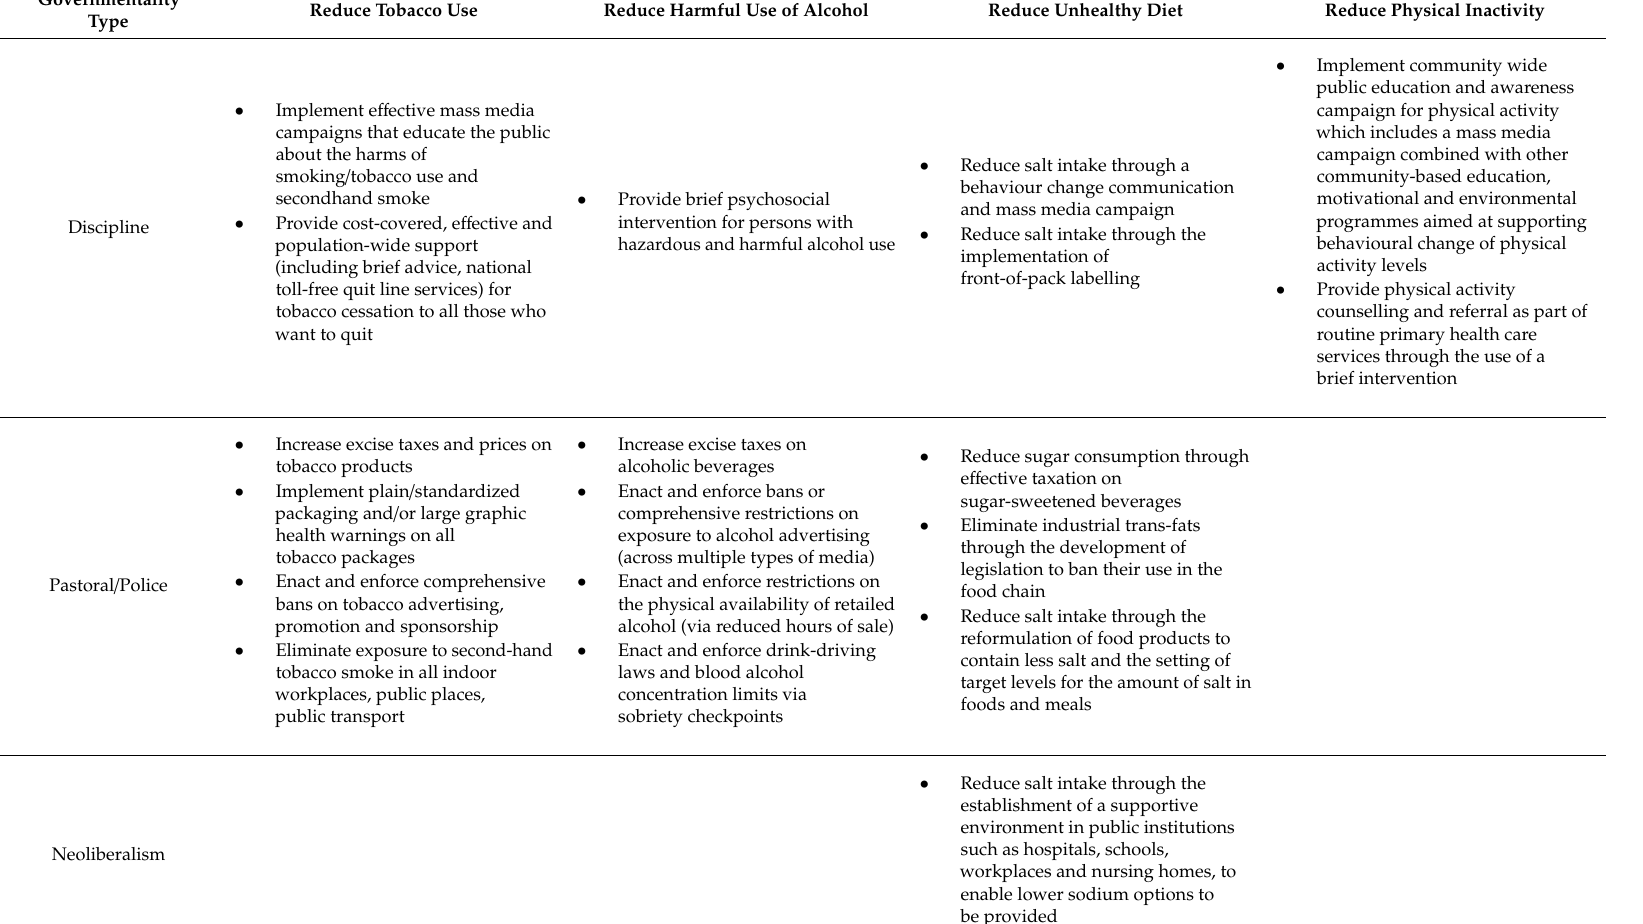
Table 2. WHO “Best buys” and other recommended interventions, WHO, 2018, by governmentality